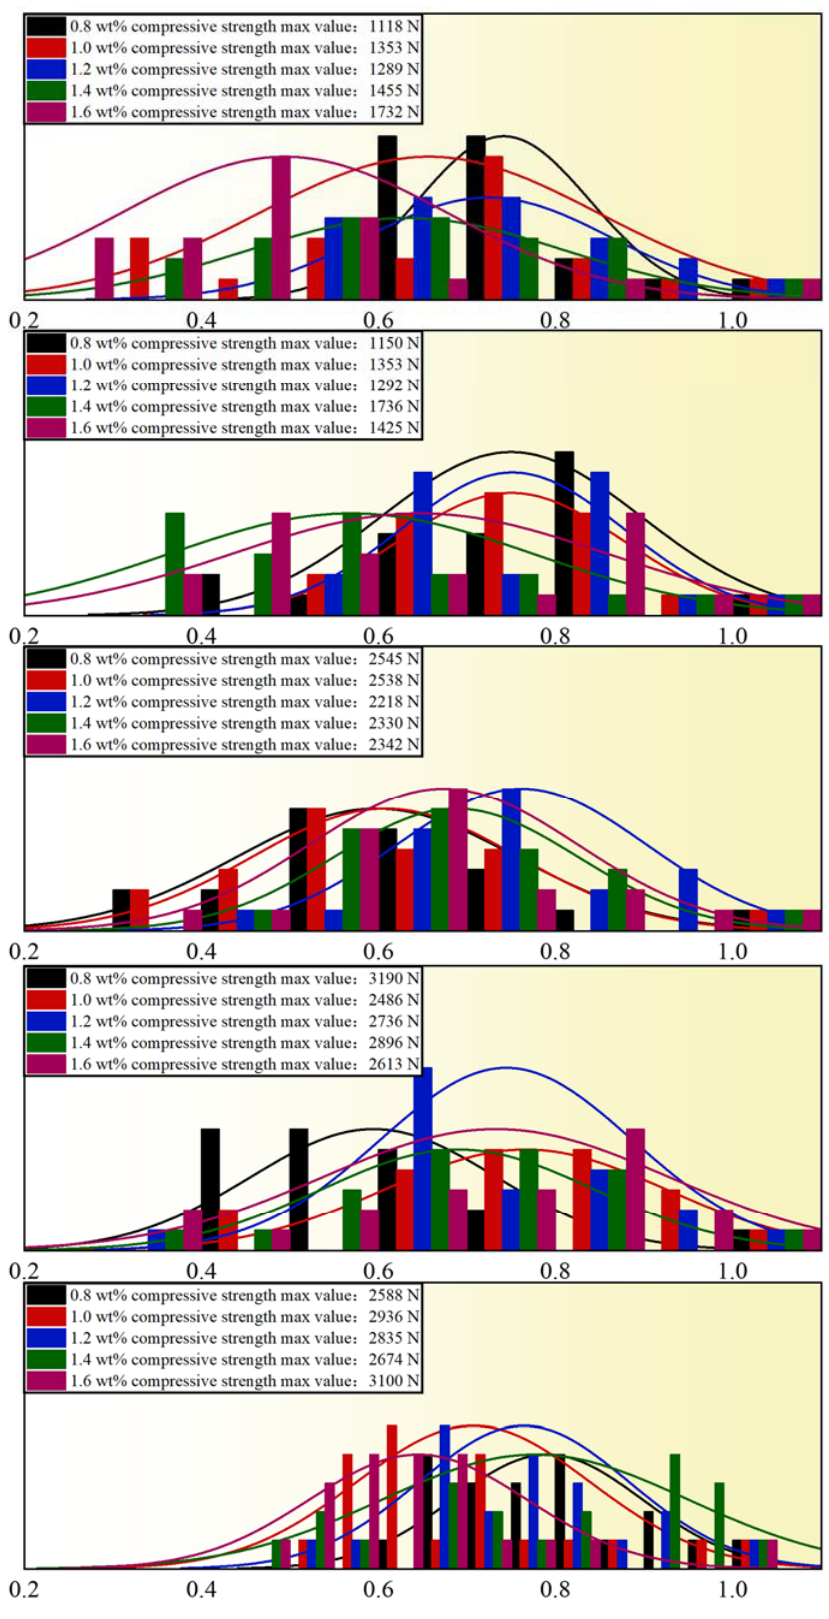
Figure 12. Normality test of pellet compressive strength under the influence of bentonite content.